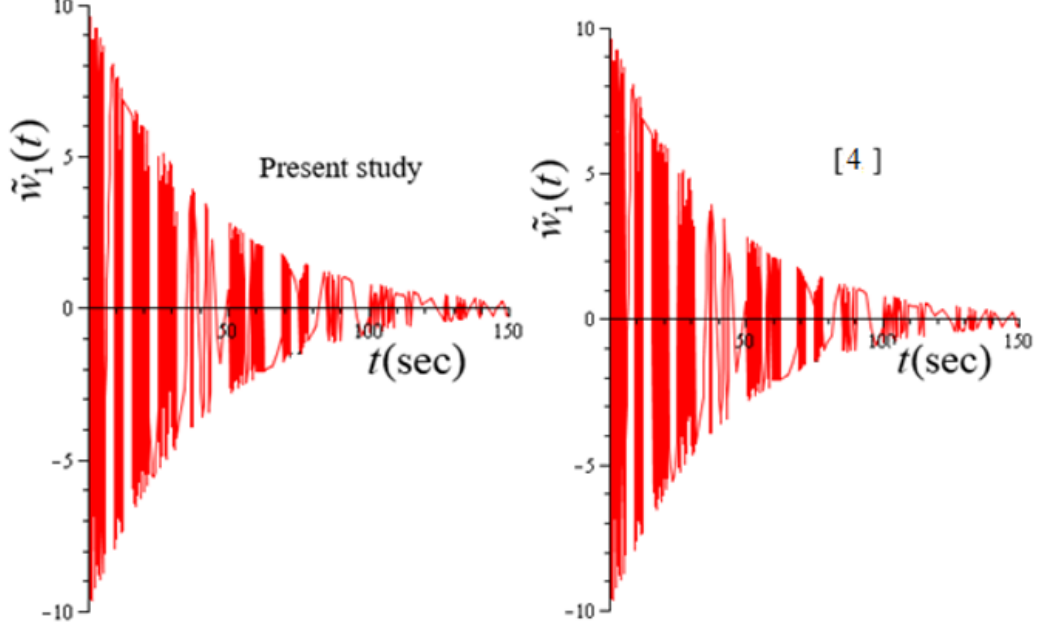
Figure 2. Comparison of our results for homogeneous isotropic VE-Ps with the results of [4].